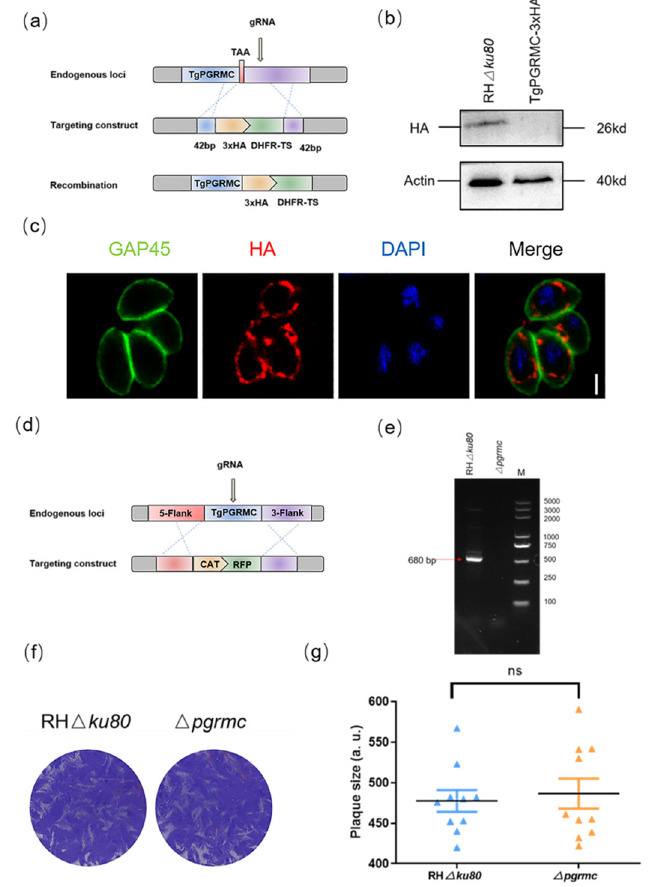
Figure 5. Phenotypic test of pgrmc gene knockout strain: ( a ) Strategy for construction of TgPGRMC- HA strain; ( b ) Western blot confirmed the expression of HA-tagged TgPGRMC in parasites. Actin was used as a control; ( c ) Immunofluorescence assays determined the localization of TgPGRMC. Parasites were labeled with mouse anti-GAP45 (green), mouse anti-HA (red), and DAPI (blue). Scale bar, 2 μ m; ( d ) Strategy for constructing Δ pgrmc strain; ( e ) PCR analysis confirmed the pgrmc gene knockout; ( f , g ) Plaque formation of RH Δ ku80 and Δ pgrmc strains for 7 days. Plaque assays were carried out three times independently (ns, not significantly).